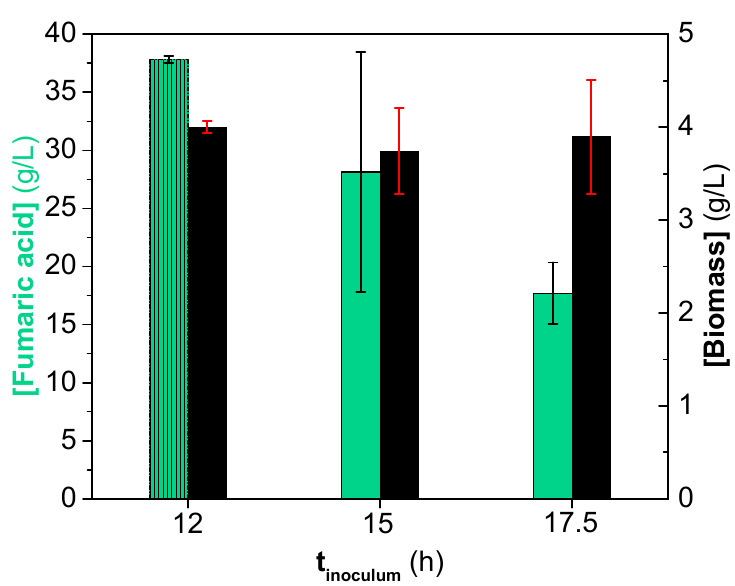
Figure 6. Inoculum age determination looking for fumaric acid production maximization by avoiding pH damage and biomass reduction.